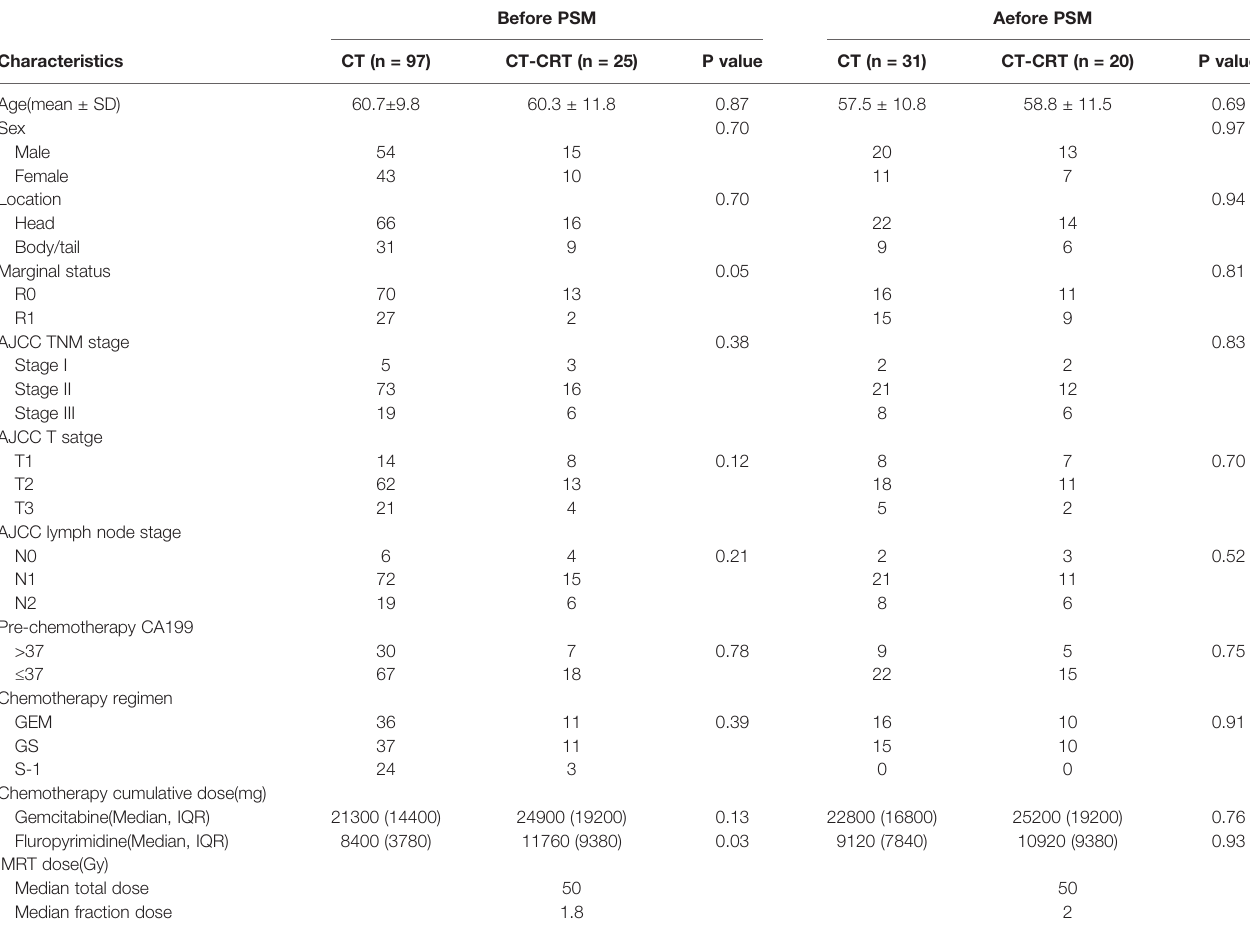
TABLE 3 | Baseline characteristics before and after propensity score matching.